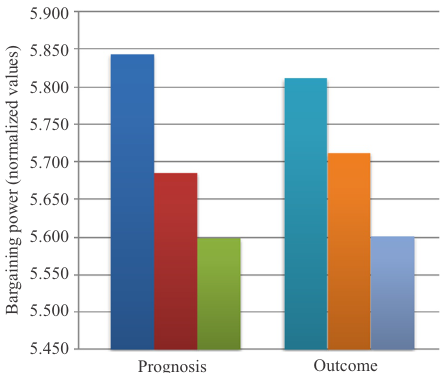
Fig. 3. The total results of the bargaining power assessment of the participants of international business negotiations in attracting